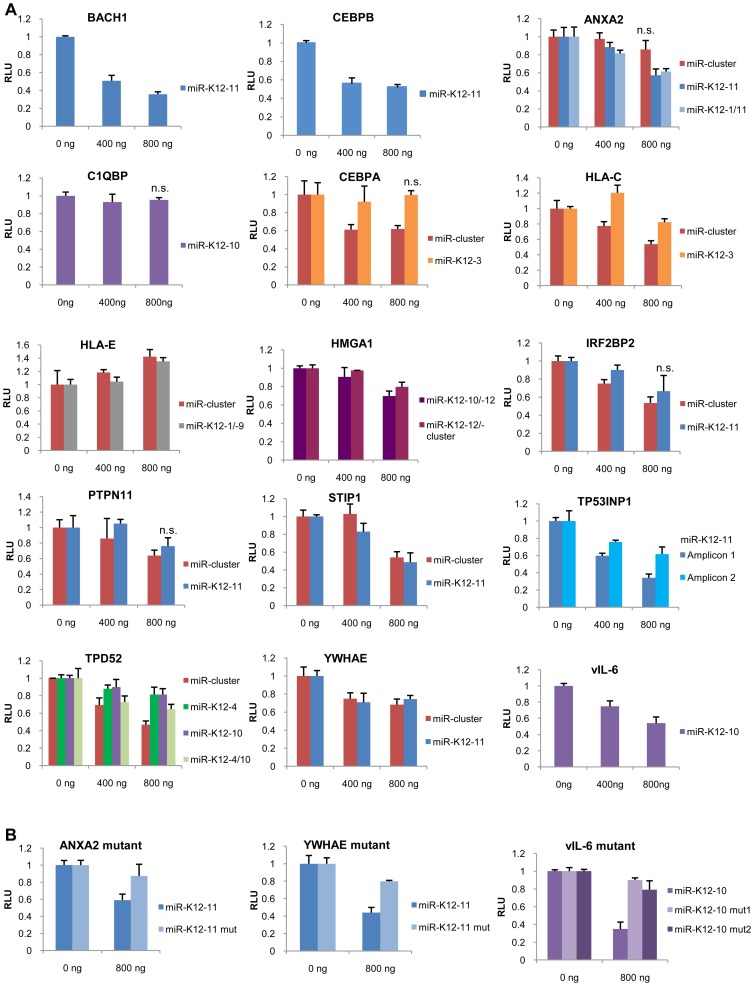
KSHV miRNA target validation by Luciferase Reporter Assay.
A) 3′UTR or coding sequences of new KSHV miRNA target genes suggested by Ago HITS-CLIP were cloned into a Firefly Luciferase reporter vector and co-transfected into HEK293 cells together with different amounts of the corresponding KSHV miRNA/miRNA-cluster expression vector (or the empty vector control) and a transfection control vector. Firefly signal was assayed 72 hrs post transfection (Figure S6) and normalized to the signal of the transfection control vector. Transfections were performed in triplicates. Error bars represent standard deviation of triplicates. Shown is one representative of ≥3 independent experiments. Significance of reporter vector repression at the highest miRNA expression vector dose (800 ng) compared to the empty vector control (0 ng) was tested by two-tailed, unpaired t-test. p<0.05 unless indicated (n.s.). Significance was not tested if RLU at 800 ng was higher than or equal to RLU at 0 ng. Out of 13 tested new targets 11 showed a dose-dependent repression of the Luciferase expression in the presence of the miRNA(s) that was significantly (p<0.05) different from the empty vector control. Previously validated targets BACH1
[22], [23] and C/EBPβ
[24] served as positive controls. RLU = relative light units. B) For three targets, ANXA2, YWHAE, and vIL-6, the seed match site was mutated (see Figure S5 and Table S8), which, in an independent series of experiments, lead to a de-repression of the luciferase signal.